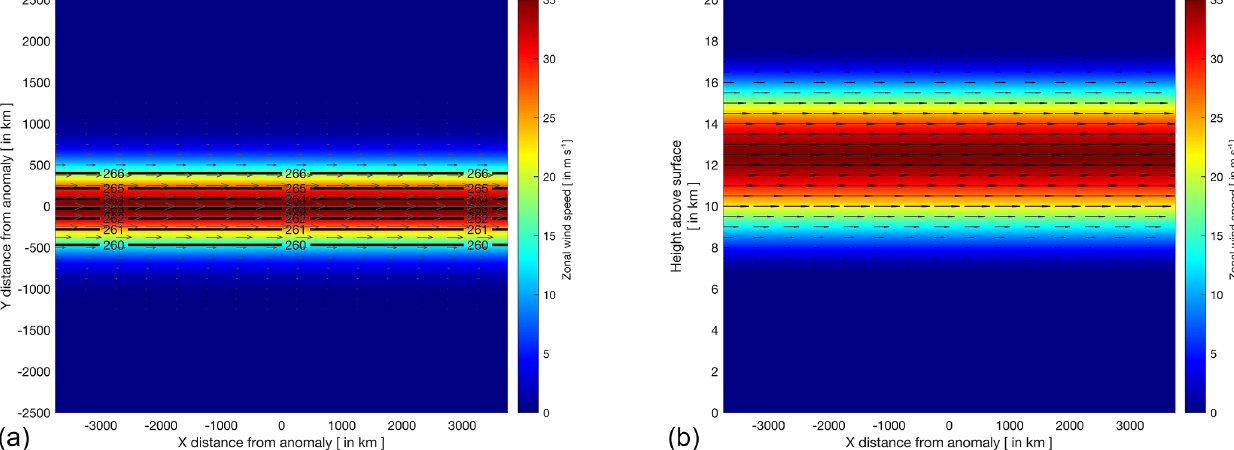
Figure 3. The jet stream of the model setup. (a) The zonal wind speed of the jet stream at the height of the given model’s tropopause (12500ma.g.l.). Pressure contours (in hPa) are overlaid together with zonal wind quivers. (b) A cross-sectional view of the zonal wind associated with the jet stream through the centre of the domain overlaid with zonal wind